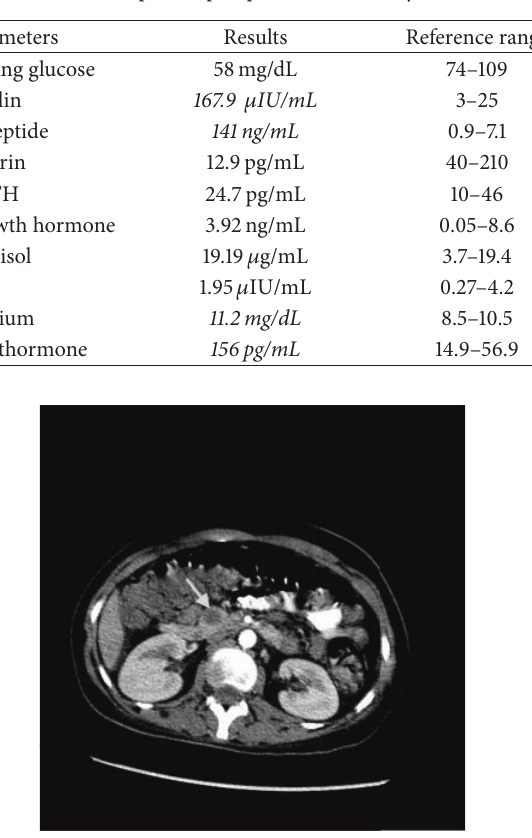
Figure 1: A hypodense mass lesion in the head of the pancreas.